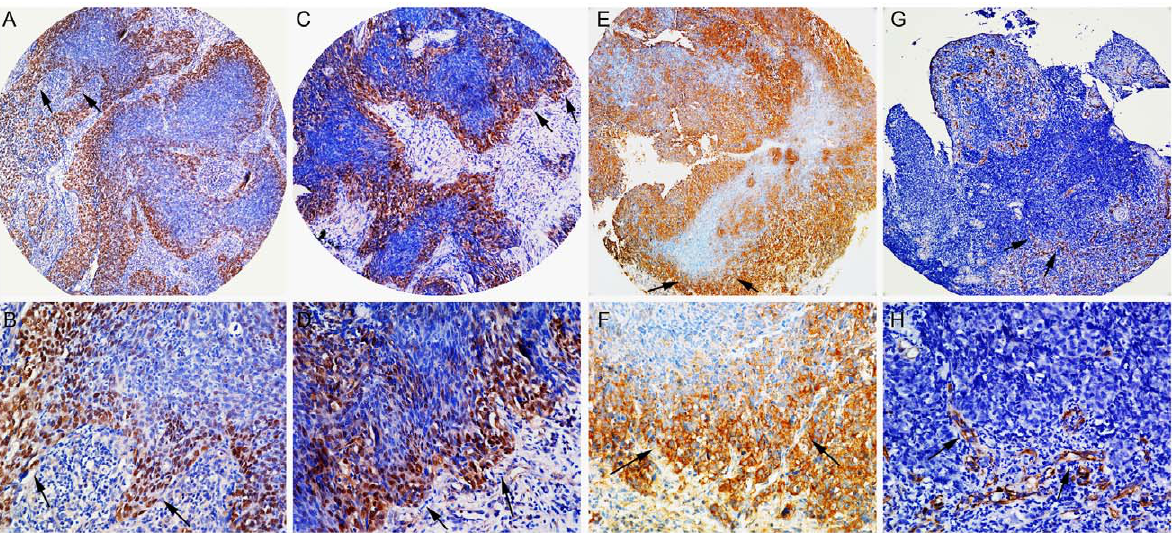
Figure 2. Immunohistochemical expression levels of SOX2, OCT4, Nanog and Nestin in the invasive front of NPC (arrows indicated). Strong staining of nuclear SOX2 (A, B) was mostly found at the tumor invasive front. High staining of nuclear OCT4 (C, D) was observed in the invasive front of tumors. Cytoplasmic Nanog expression (E, F) was particularly evident at the invasive edge of tumors. Of note , these cells often exhibited a fibroblast-like, spindle-shaped phenotype. On the other hand, Nestin expression in blood vessels (G, H) were distributed predominantly at the invasive front of tumors. (A, C, E, G 6 100; B, D, F, H 6 400, respectively).